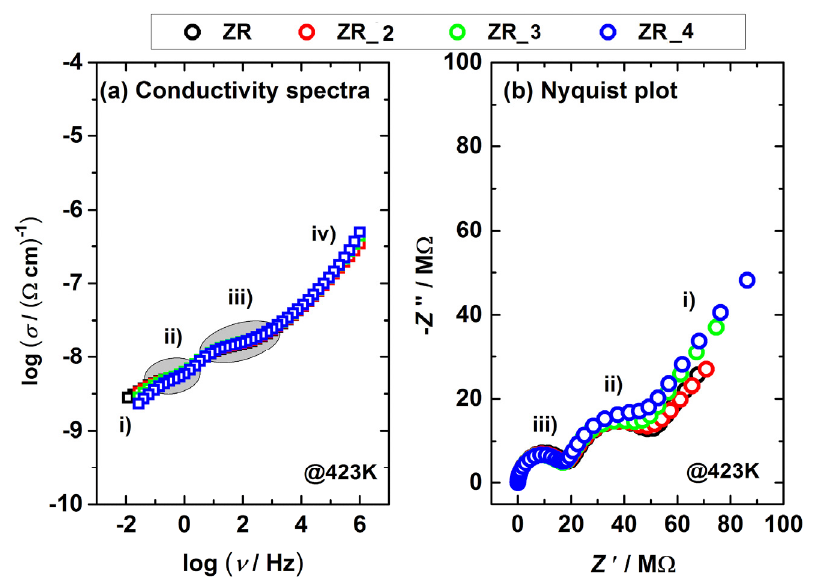
Figure 5. ( a ) Conductivity and ( b ) Nyquist spectra obtained at 423 K for selected samples (the control ZR and the sandblasted ZR_2, ZR_3, ZR_4). Different regions are marked as follows: (i) decrease/spur at lowest frequencies, (ii) low-frequency, (iii) middle-frequency region and (iv) dispersion (frequency- dependent region).